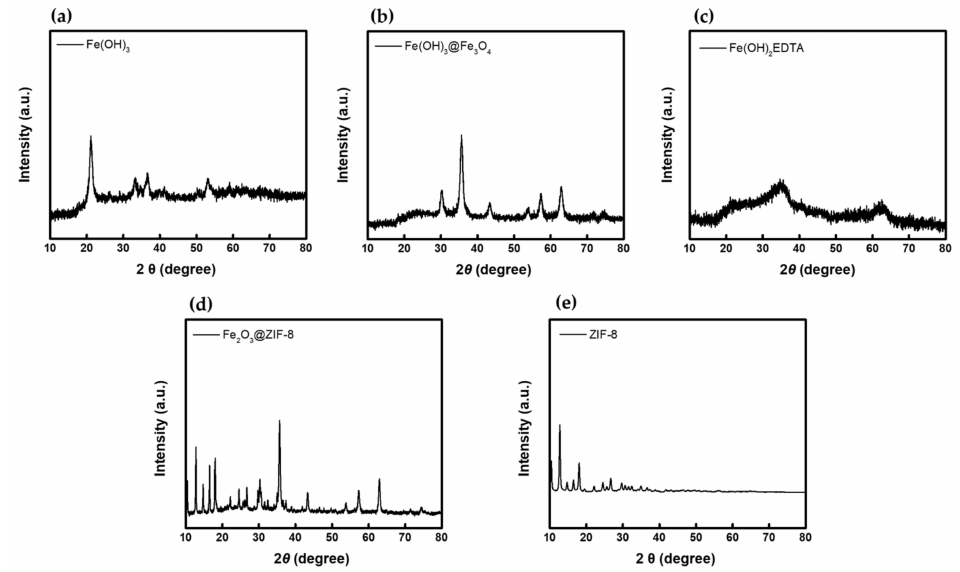
Figure 5. XRD spectra of ( a ) Fe(OH) 3 , ( b ) Fe(OH) 3 @Fe 3 O 4 , ( c ) Fe(OH) 2 EDTA, ( d ) Fe 3 O 4 @ZIF-8, and ( e )